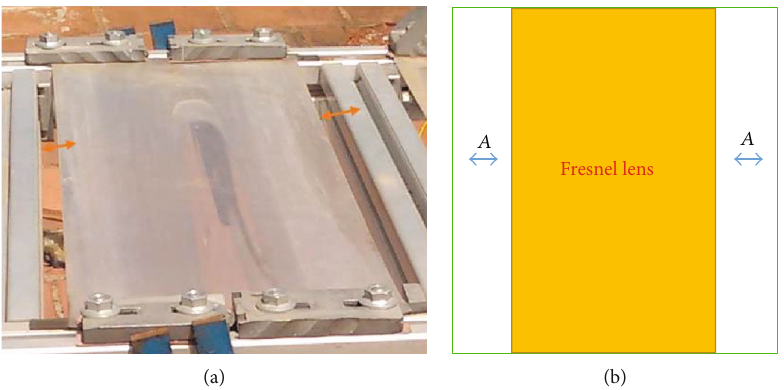
Figure 4: Top view of the Fresnel lens: (a) photograph and (b) line diagram.